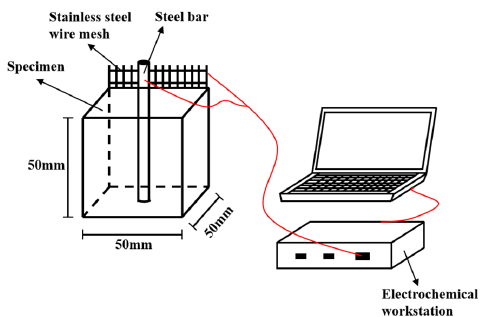
Figure 5. Measurement of AC electrical parameters.